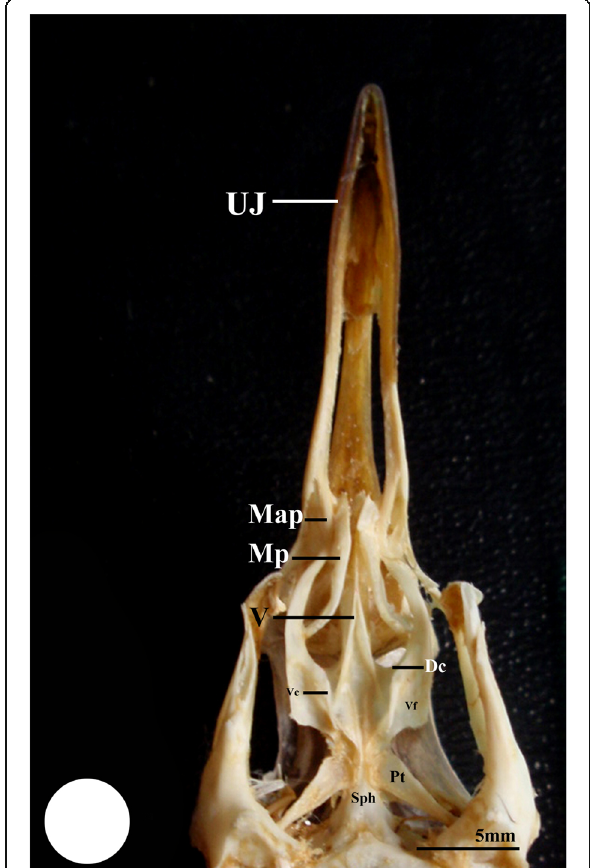
Fig. 6 Photograph of ventral surface of skull of common moorhen shows upper jaw (UJ), the maxillary process of the palatine bone (Map), maxillopalatineprocess (MP), vomer bone (V), choana fossa (Fc), ventral crest (Vc), dorsal crest (Dc), ventral fossa (Vf), Pterygoid (Pt), and parasphenoid (Sph)